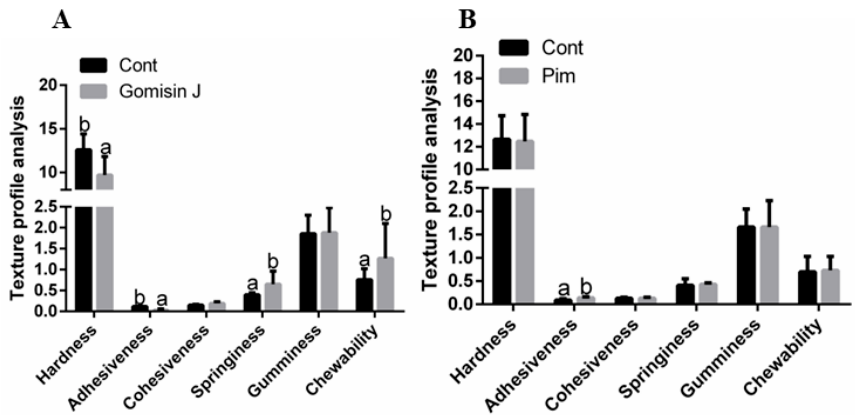
Figure 6. The effects of Gomisin J and Pim on triploid crucian carp muscular texture features at different time points. ( A ) The effects of Gomisin J on muscular texture features at 15 days. ( B ) The effects of Pim on muscular texture features at 9 days. Data are presented as means ± SE ( n = 3). Different letters indicate significant differences ( p < 0.05).